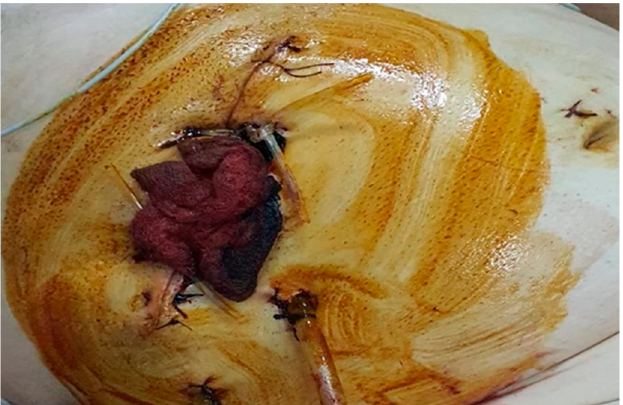
Figure 2. The external extensions of the perihepatic meshes.